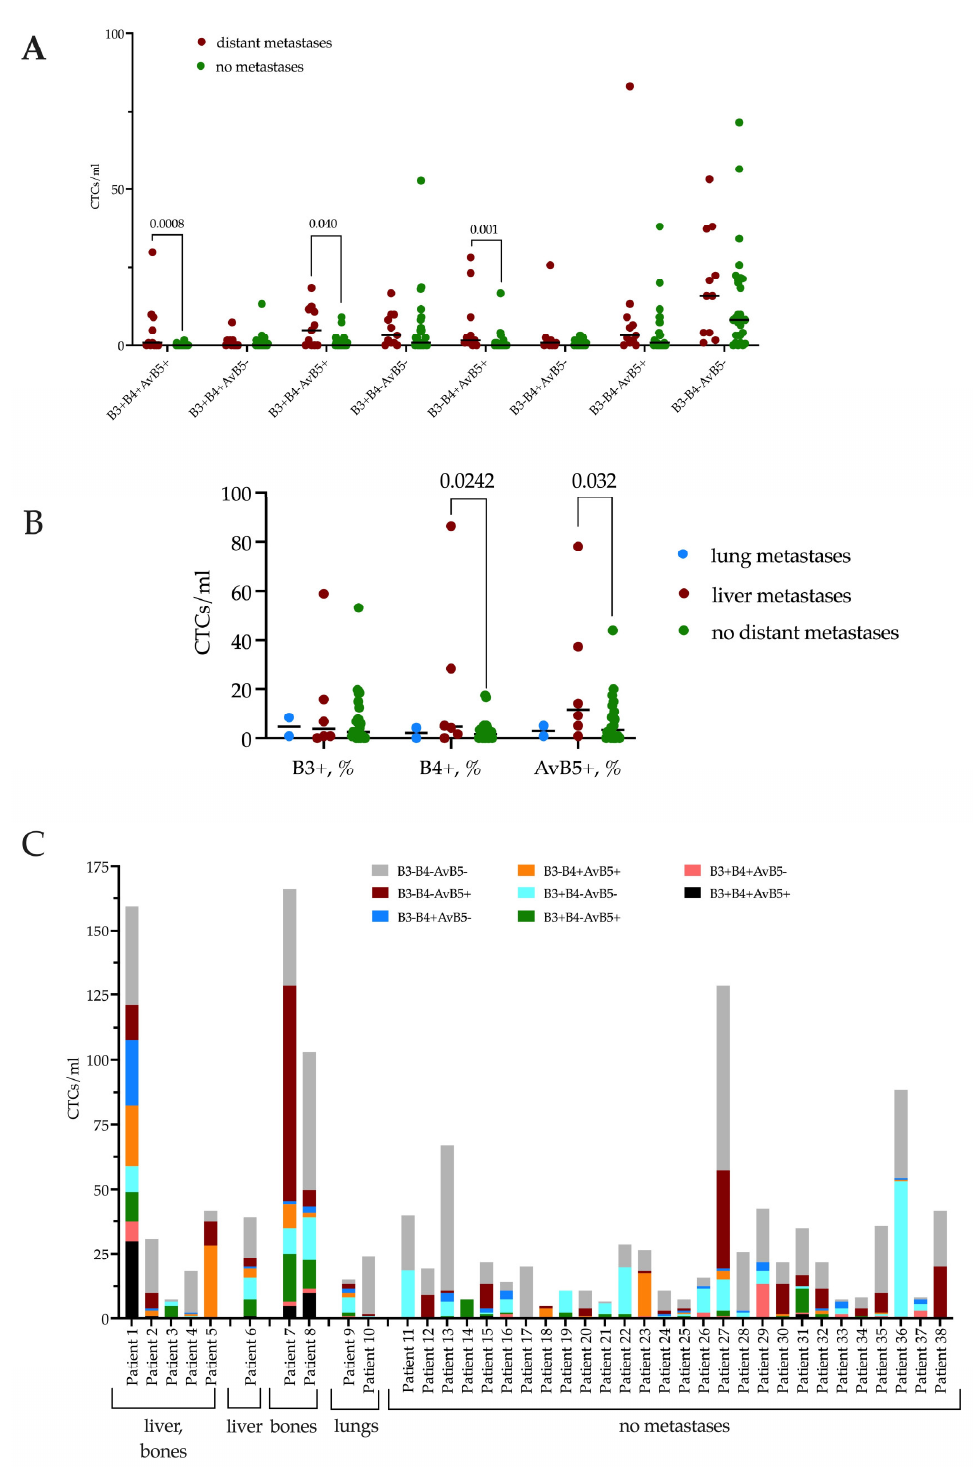
Figure 2. ( A ) Number of CTC co-expressed β3, β4, and αVβ5 integrins in breast cancer patients. ( B ) Number of CTC co-expressed β3, β4, and αVβ5 integrins in breast cancer patients with distant metastases in different organs. ( C ) Intrapersonal variants of integrins co-expression in CTCs of each breast cancer patient. Samples were tested for statistical outliers, then one-way ANOVA was used to compare the means of independent groups.